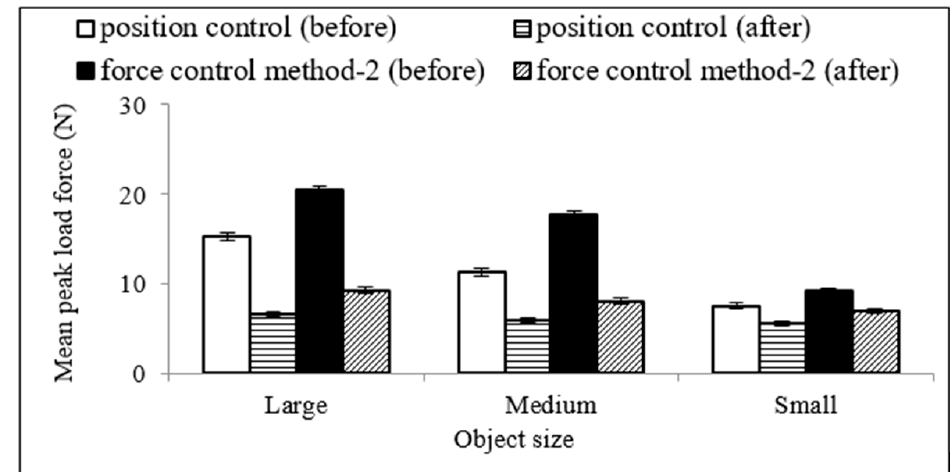
Figure 9. Mean ( n = 20) peak load force for the position control and force control scheme/method 2 for objects of different sizes before (experiment 1) and after (experiment 2) the implementation of the novel adaptive control algorithm.